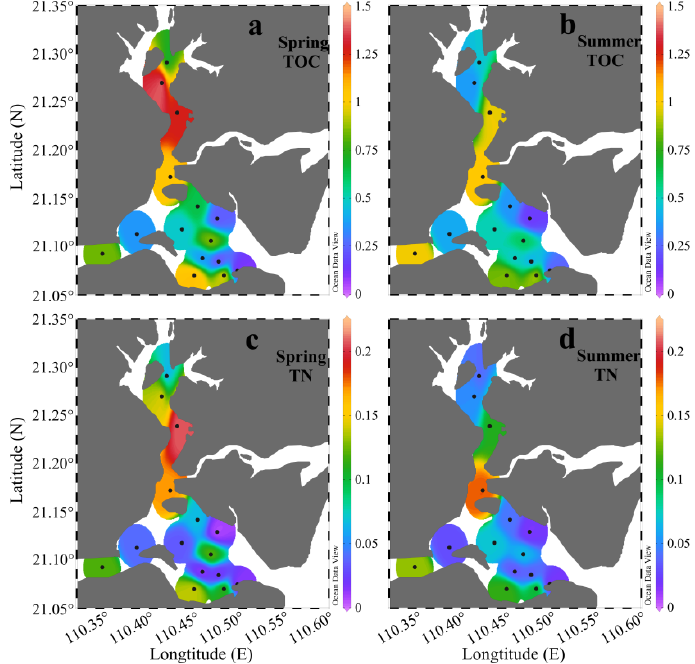
Figure 4. Spatial variations in the TOC ( a , b ) and TN ( c , d ) in the surface sediments of Zhanjiang Bay in spring and summer (unit: %). Table 3. Relationship between sediment carbon and nitrogen parameters and sediment grain-size fractions in spring and summer.